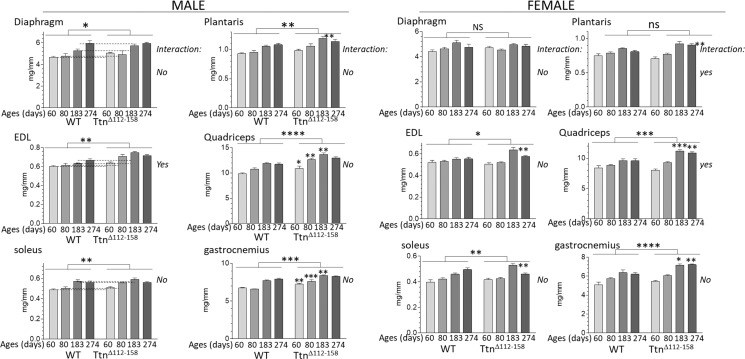
Muscles of Ttn∆112-158 mice are hypertrophied.Hypertrophy is expressed as muscle weight (mg) normalized to tibia length (mm). Two-way ANOVA reveals a significantly increased hypertrophy in most muscle types of the Ttn∆112-158 mice. Most of the muscle types do not have a significant interaction term with age indicating that the genotype effect on muscle weight does not vary with age.